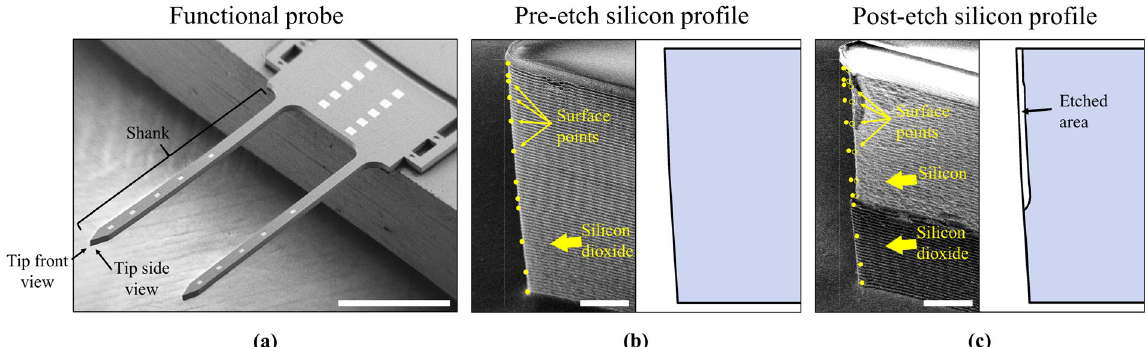
Fig. 6 Overview of 3D extrapolation method based on SEM images. a A functional probe with an arrow indicating the SEM viewing direction ( “ tip side view ” ). The scale bar is 1 mm. b On the left is data collection from an SEM side view of the probe tip with sidewall surface points before KOH etch (solid circles). The scale bar is 10 µm. On the right is the side view of the generated model in SolidWorks based on those surface points. c Data collection from an SEM image after 30 min KOH etch with surface points (hollow circles). The scale bar is 10 µm. Right is the side view of the generated model in SolidWorks. The reduction in volume after 3D extrusion de fi ned the etched